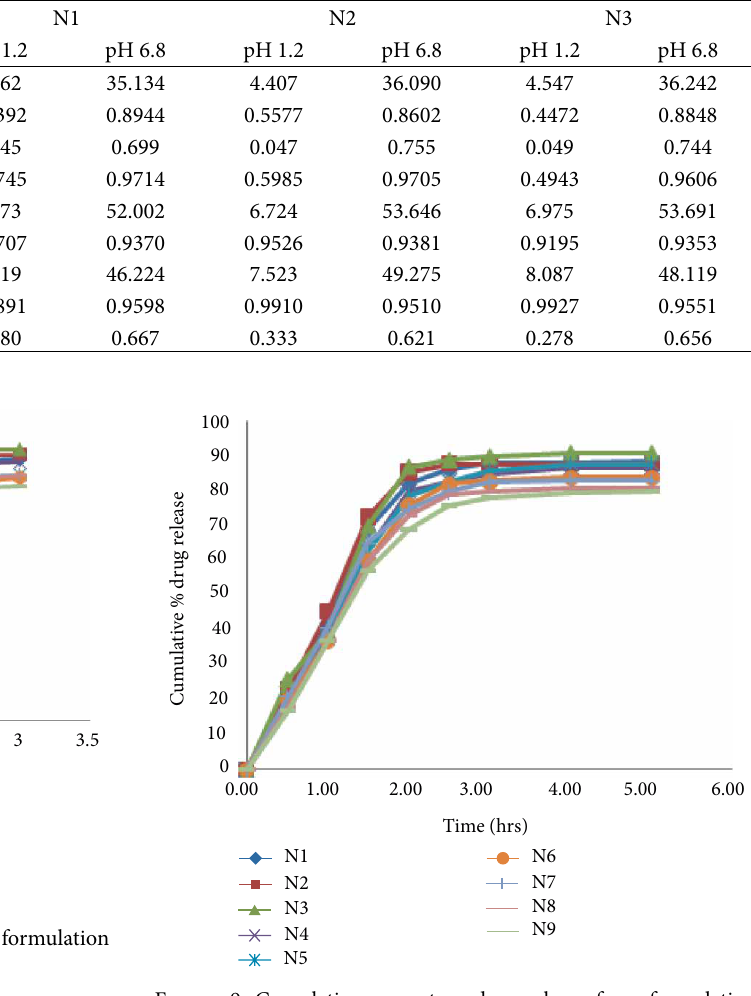
91%. Maximum drug release was presented by formulation PM3 that was 91%. Such pH dependant release from these